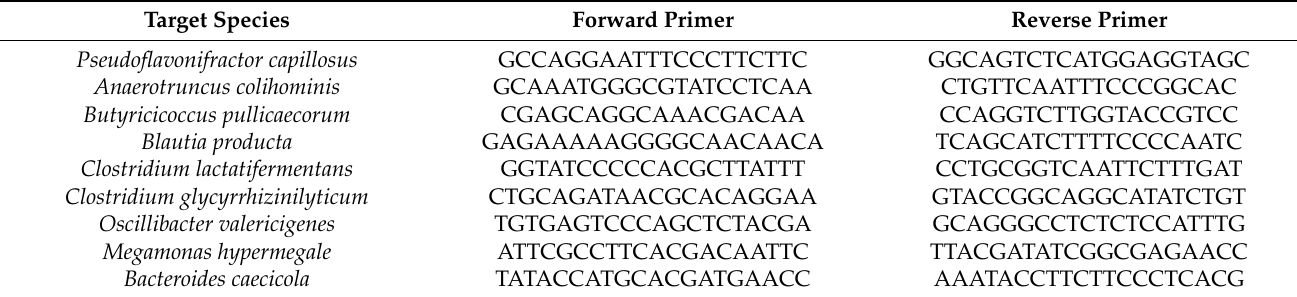
Table 1. List of primers used for the detection and quantification of target bacterial